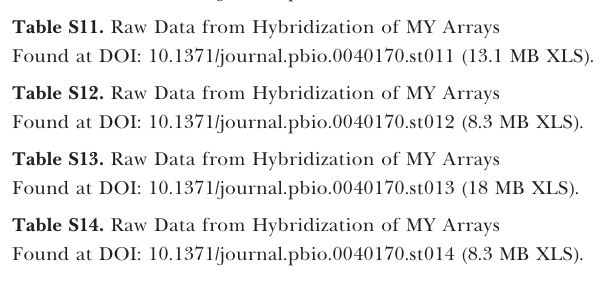
Table S10. Raw Data from Hybridization of MY Arrays